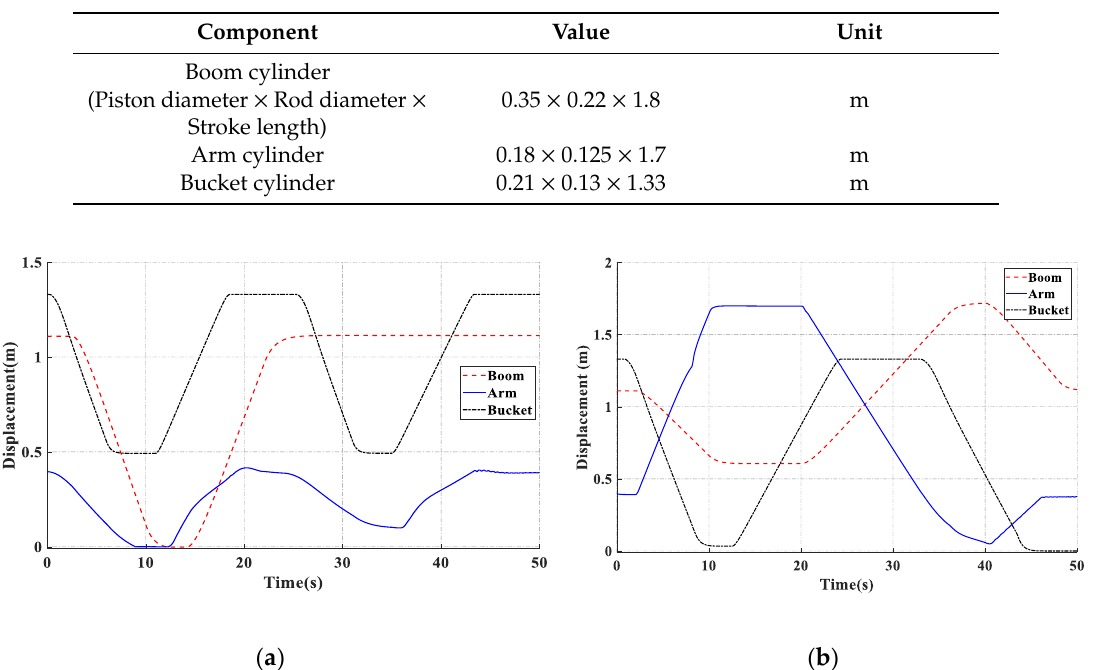
Table 5. Parameters for the excavator model.